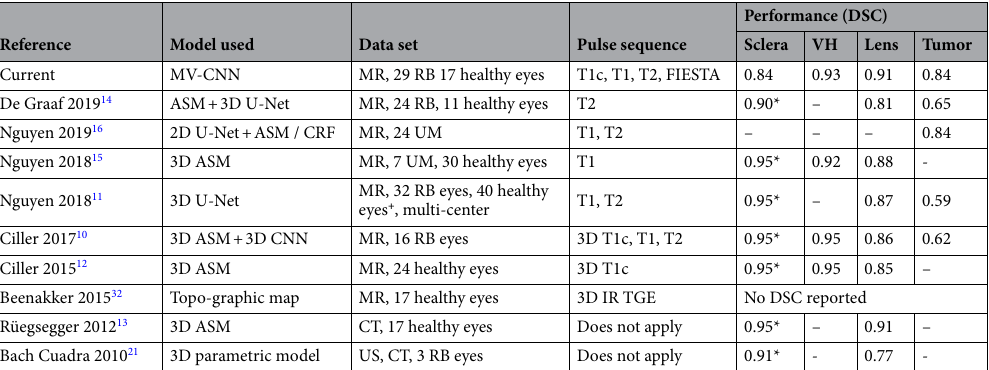
Table 2. Literature overview of eye and tumor segmentation methods and performances. DSC dice similarity coefficient; VH vitreous humour; MV multi-view; CNN convolutional neural networks; MR magnetic resonance; ASM active shape model; CRF conditional random field; UM uveal melanoma; RB retinoblastoma; IR inversion recovery; TGE turbo gradient echo; CT computed tomography; US ultrasound; T1c T1 with gadolinium contrast. *Includes vitreous humour. + Includes child and adult